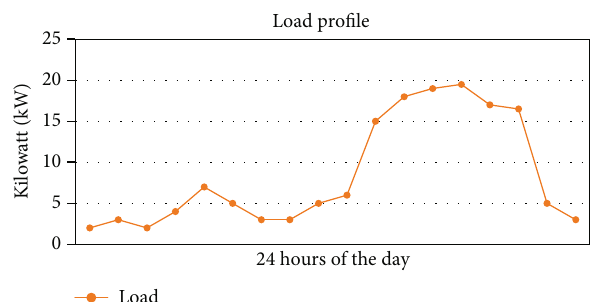
Figure 6: Daily load pro fi le of